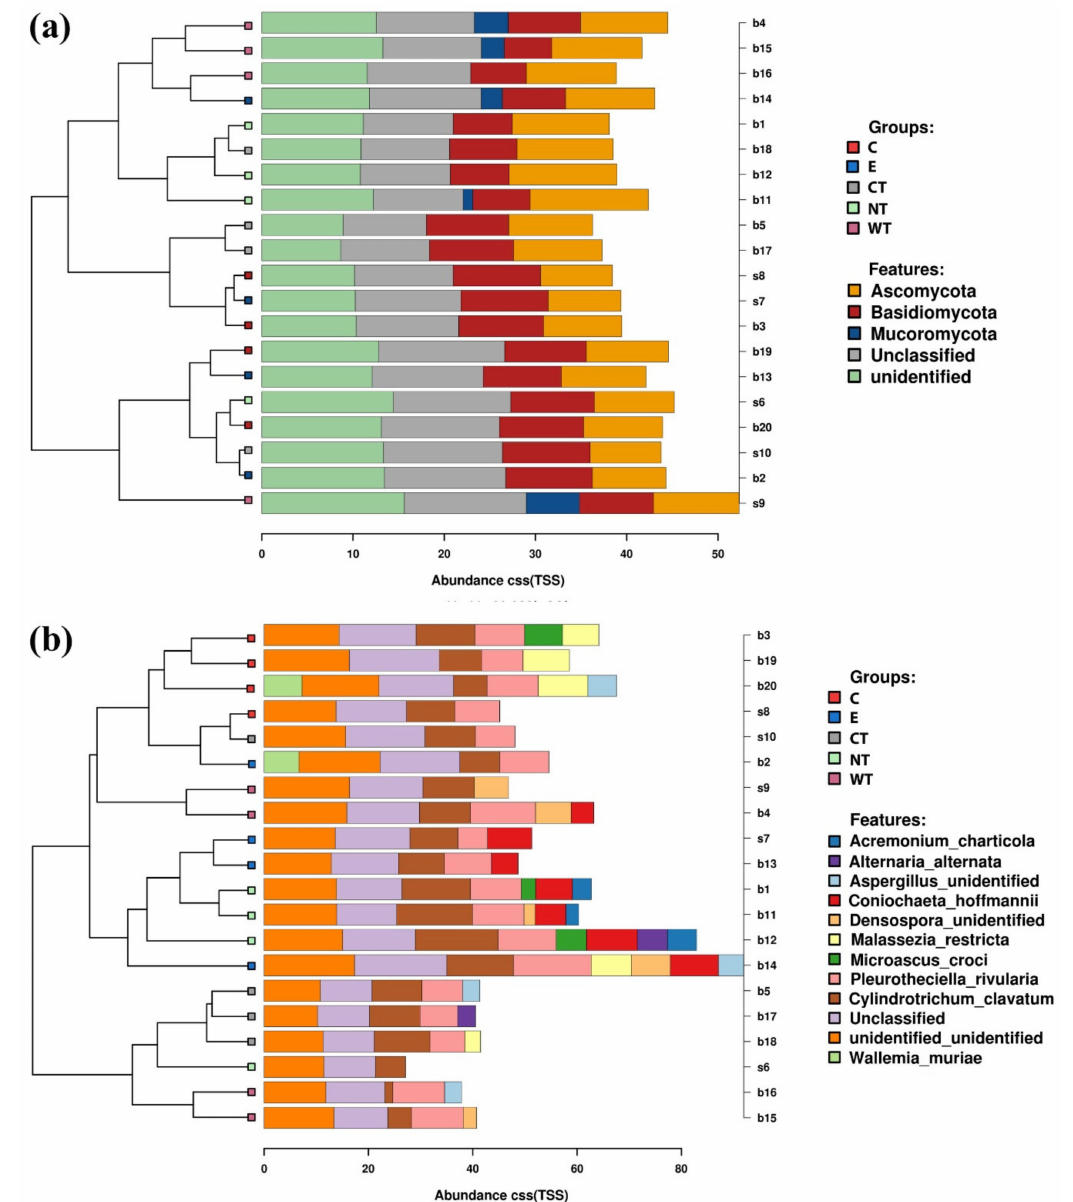
Figure 5. Stacked barcharts showing the relative abundance of fungal phyla ( a ) and species ( b ) in each sample. Tips of the clustering tree are colored according to the treatments. (C: cinnamon; E: ethanol; CT: common thyme; NT: not-treated control; WT: wild